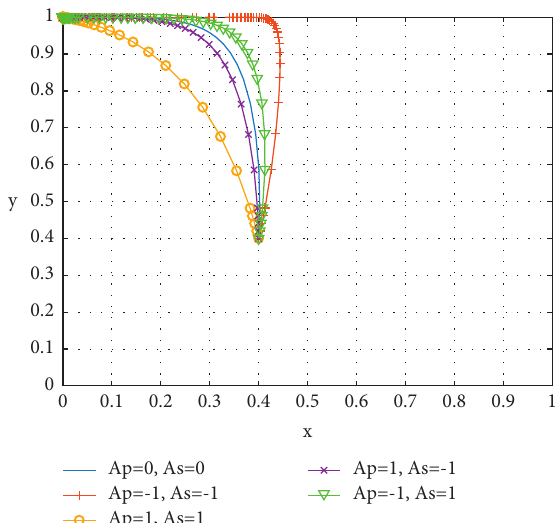
Figure 7: Evolution results with the change of risk attitudes by the initial values in Case